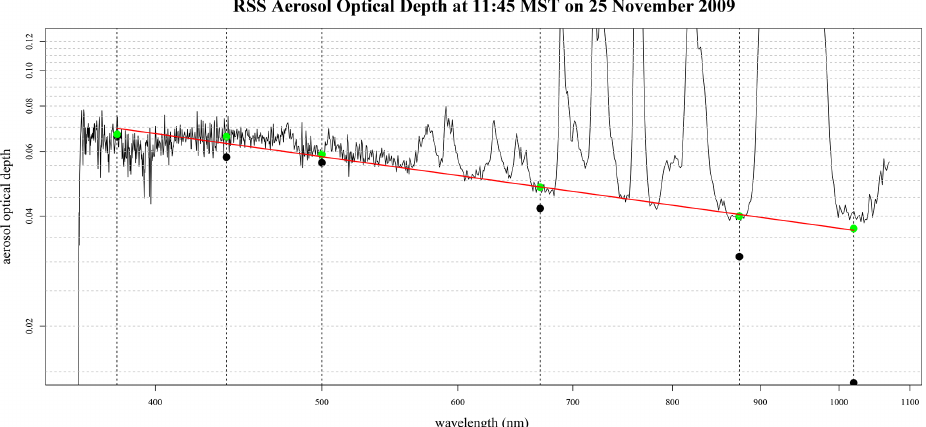
Figure 10. RSS aerosol optical depth versus wavelength at 11:45LST (local standard time) at the ARM central facility in northern Oklahoma. The vertical lines are drawn at the wavelengths used in the Cimel Sun photometers employed by AERONET (AErosol RObotic NETwork) for measuring AODs in this part of the spectrum. The O 2 and H 2 O bands have been truncated at 0.12 optical depth to better see the aerosol wavelength dependence. The approximated RSS AOD (green dots) versus the wavelength for pixels at AERONET wavelengths are shown. The least squares fit to the RSS points yields an Ångström exponent equal to 0.52. The filled black dots are the AERONET points taken 2.5min after the RSS data. Except for 1020nm, the agreement is within 0.01 AOD. The 1020nm (green) point for the RSS is lower by 0.003 because an additional correction was made for water vapor at that wavelength.